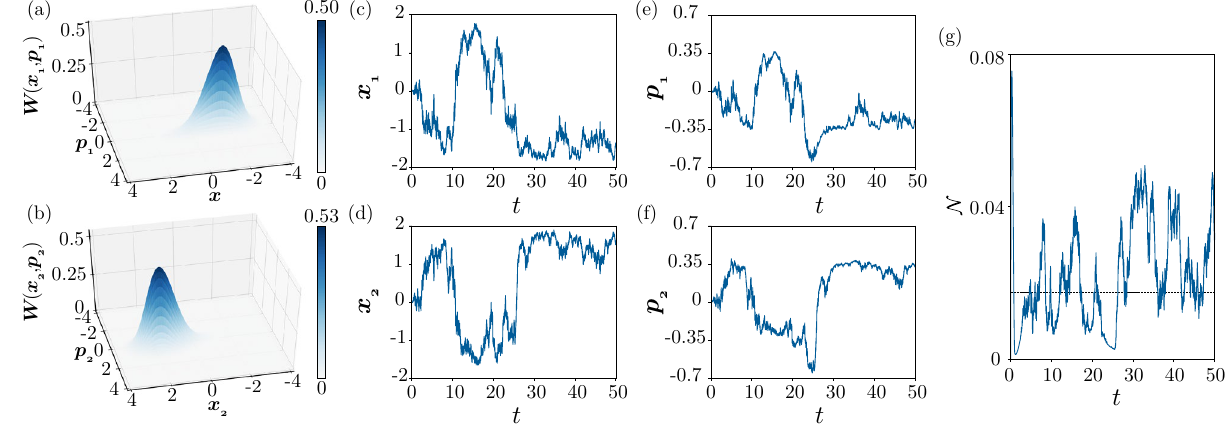
Figure 7. Turing instability under continuous quantum measurement in the semiclassical regime. ( a , b ) 3D snapshot plots of the Wigner distributions W ( x 1 , p 1 ) and W ( x 2 , p 2 ) at t average values of the position and momentum operators for two units: ( c ) ( g ) Time evolution of the negativity N . The parameters are � 1 ( D 0.005 and D 0.995 ), and φ 0.99 , D D h c = x = p = = − line represents the value for the steady state of the system without performing